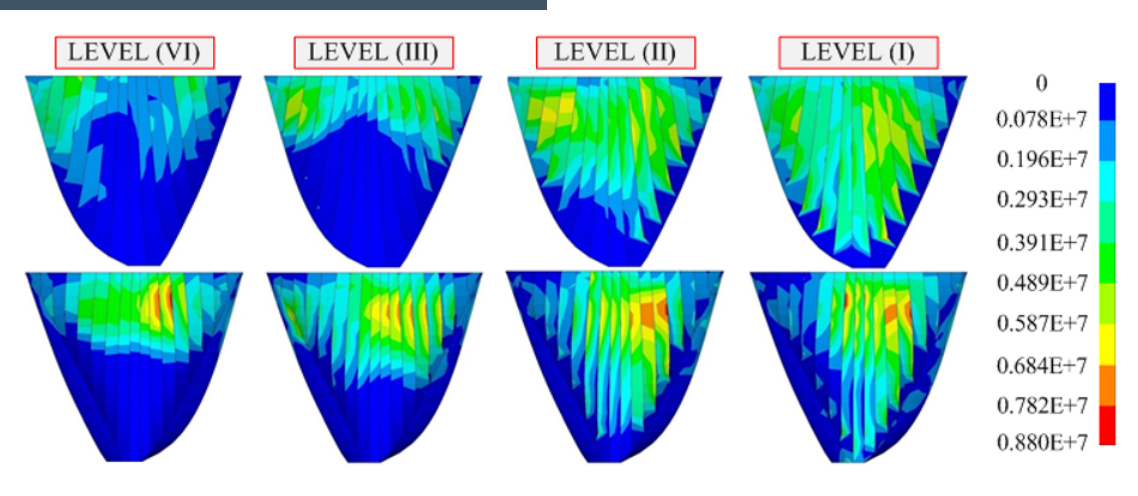
Figure 18. Non-concurrent envelope of the maximum first principal stresses ; (Pa)